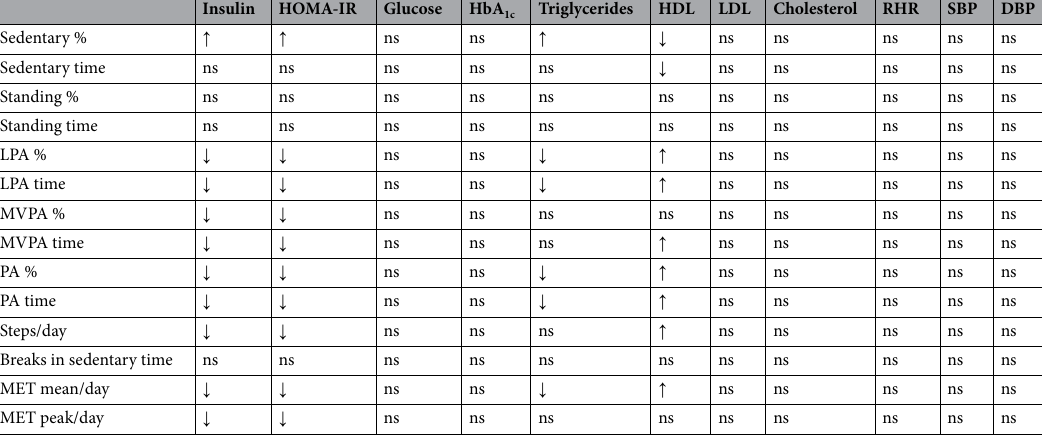
Table 8. Summary table, associations between accelerometer measures and metabolic outcomes derived from clinical investigation and fasting blood samples measured by linear models with age, sex and BMI included in the analyses . For lipid-related outcomes, the possible use of cholesterol-lowering medication (statins) was included the model; and for blood pressure-related outcomes, the possible presence of medical treatment of hypertension was included the model. HOMA-IR homeostasis model for insulin resistance, HbA1c glycated hemoglobin, HDL high density lipoprotein, LDL low density lipoprotein, RHR resting heart rate, SBP systolic The significant positive and negative associations are indicated by upward ↑ and downward ↓ arrows,